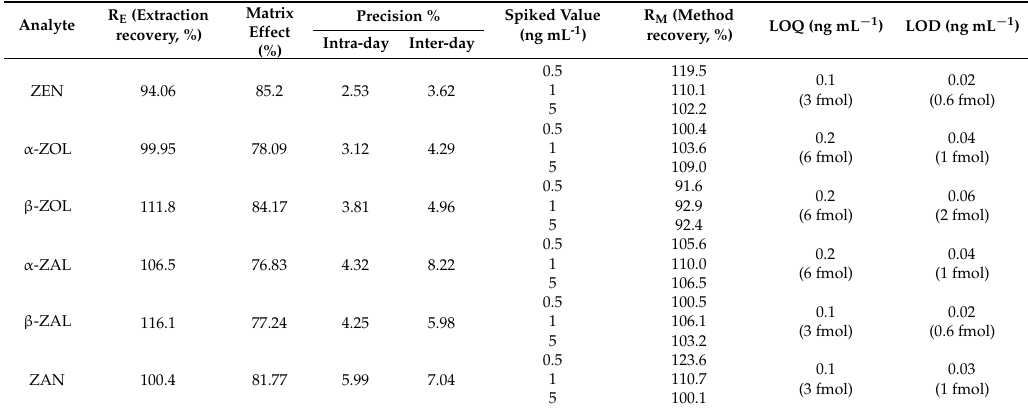
Table 2. Extraction recovery, matrix effect, accuracy, precision and sensitivity of the method. Analyte R E (Extraction recovery,